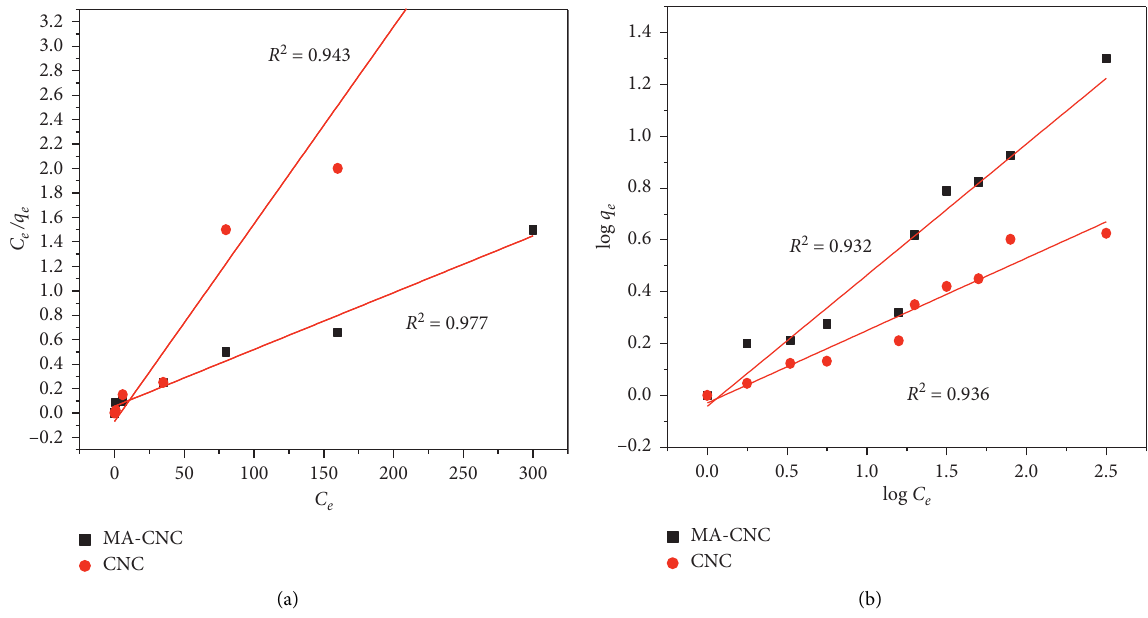
Figure 9: Langmuir (a) and Freundlich (b) adsorption isotherm for the removal of Cd(II) ions, respectively, at C